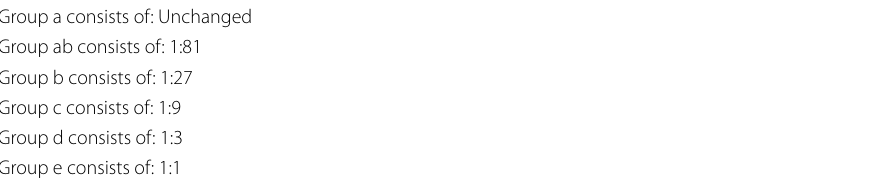
Table 35 HSD test groupings after ANOVA of AUPRC for the RUS factor